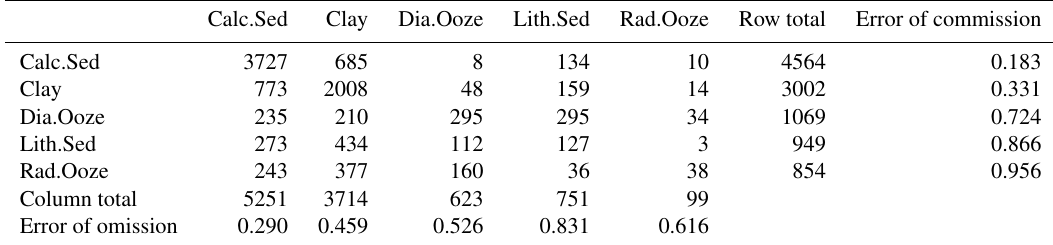
Table 3. Confusion matrix. Observed (reference) classes are in columns; predicted classes are in